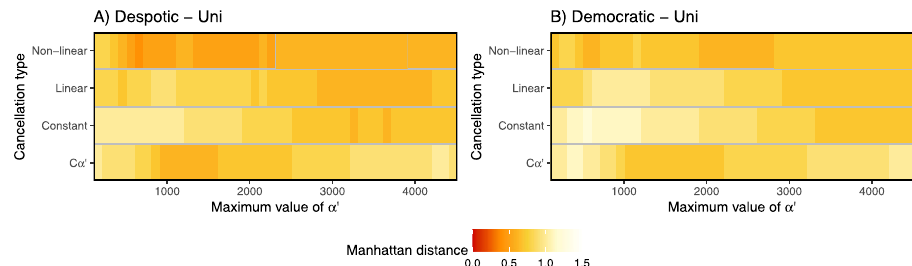
Fig. 5 Manhattan distance between the distribution of the number of individuals involved in each initiation generated by our simulations and the one observed in the fi eld for a group of Capuchin monkeys. The Manhattan distance was obtained by computing the difference between fi eld and simulation data for each bar of the histogram showing the number of individuals moving in each initiation. The lower the index of Manhattan distance, the greater the agreement between both distributions. A Results under a despotic scenario and Uni condition and B under a democratic scenario and Uni condition, both considering non-linear, linear, constant, and C α ’ types of cancellation rate ( y -axis). The fi rst column of the x -axis corresponds to the control simulation without personality as α ’ = 160 for all individuals. For the following columns the minimum value of α ’ = 10 and the maximum value of the distribution is given by the x -axis. The probability of joining per second (one timestep) is equal to 1/ α ’ .